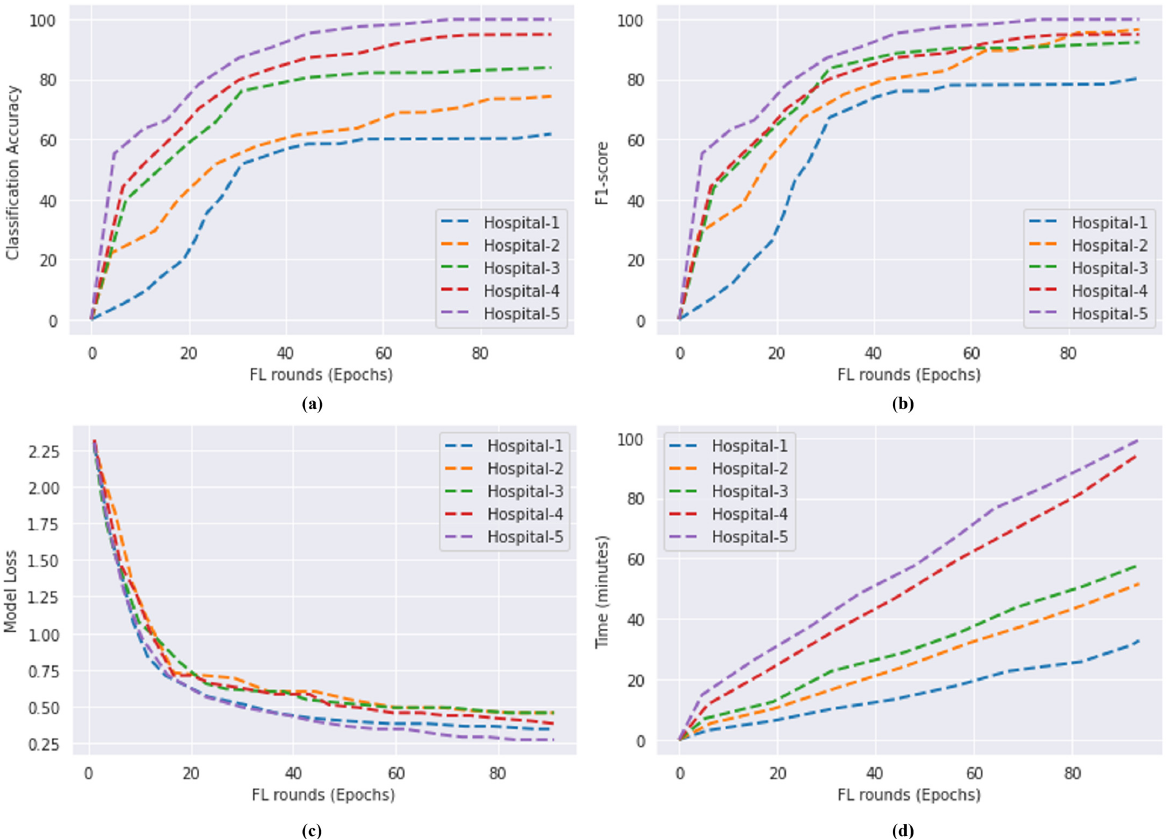
Figure 9. A result achieved by the proposed blockchain-based FL model. ( a ) Accuracy of the proposed model on COVID-19 CT scan dataset for five different hospitals. ( b ) F1-score of the proposed model; ( c ) model loss on COVID-19 CT scan dataset five different hospitals. ( d ) Time of COVID-19 CT scan dataset for five different hospitals using FL.